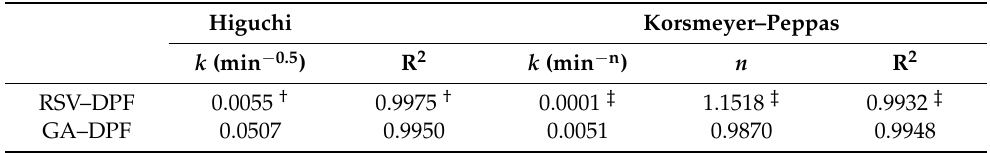
Table 7. Kinetic constants obtained through the fitting of the RSV and GA release profiles (pH 5.5 PBS and at 32 ◦ C) using the Higuchi and Korsmeyer–Peppas mathematical models.